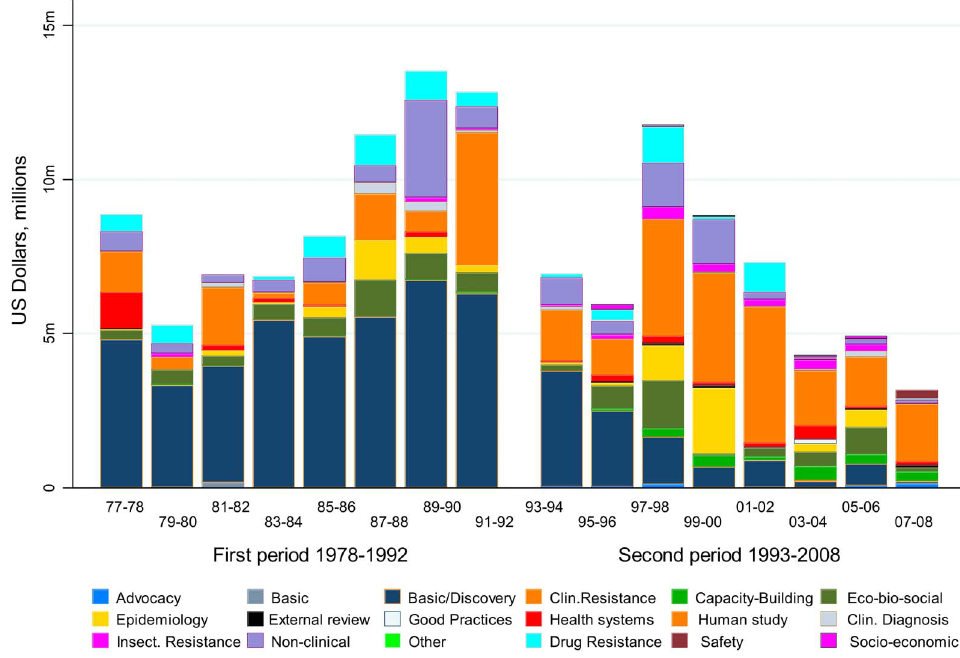
Fig. 4. Variety of disciplines involved in malaria research funded: committees 1977–1992 versus task forces 1993–2008.